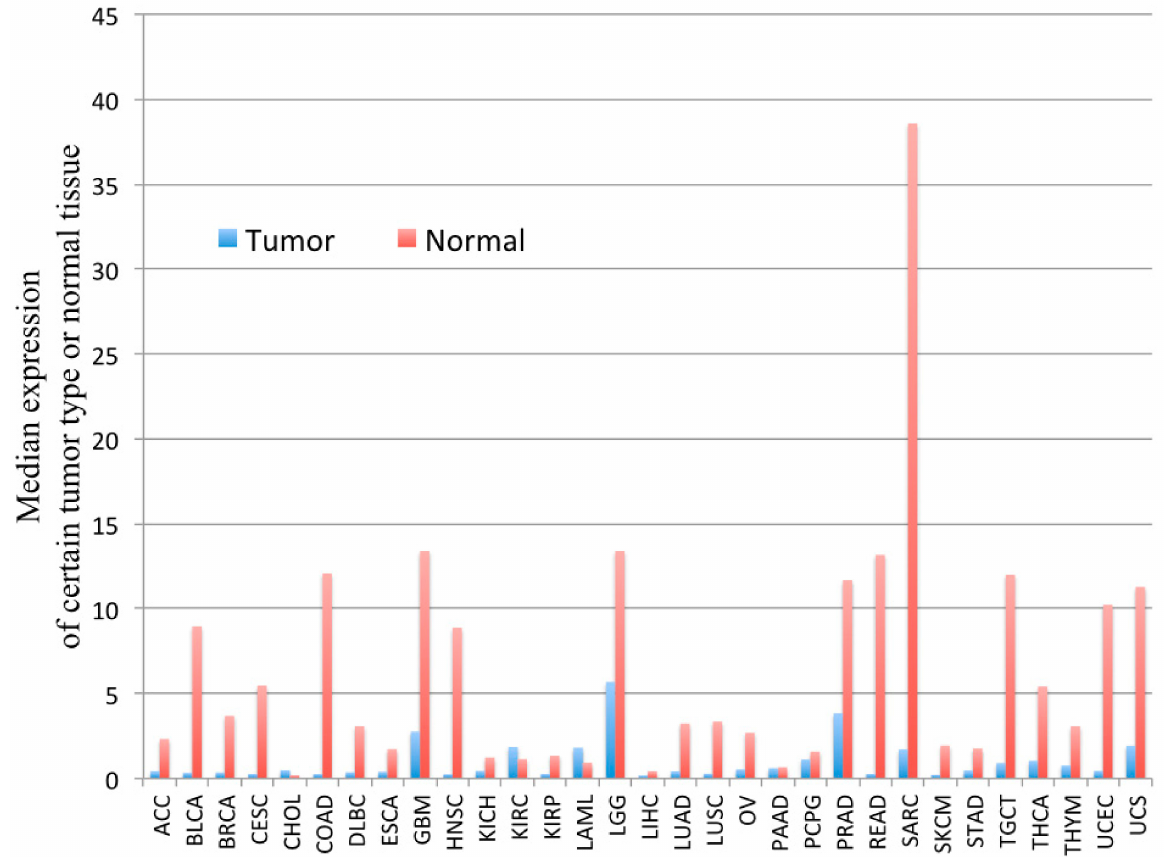
Figure 2. The PYGM gene expression profile across tumor samples and corresponding normal tissues. The height of the bar represents the median expression of a certain tumor type (blue) or normal tissue (red). ACC—adrenocortical carcinoma, BLCA—bladder urothelial carcinoma, BRCA—breast invasive carcinoma, CESC—cervical squamous cell carcinoma